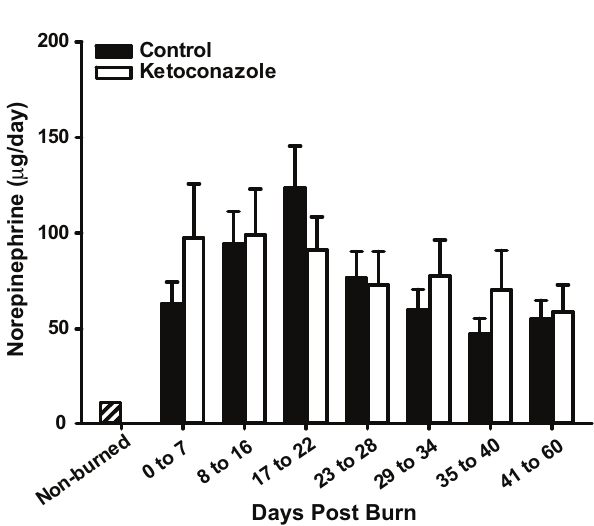
Figure 3. Nor-epinephrine levels are not altered by ketocona- zole administration. Data are presented as mean 6 SEM. Norepi- nephrine was significantly elevated post-burn compared to normal values ( p ,